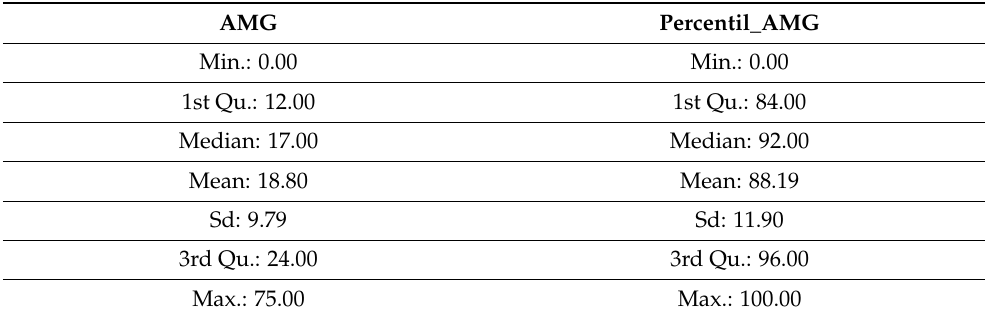
Table 2. Variables of the Adjusted Morbidity Groups (AMG) of persons over 65 years of age living alone. Basic Health Areas of Gran Canaria. 2018–2020. Descriptive. AMG